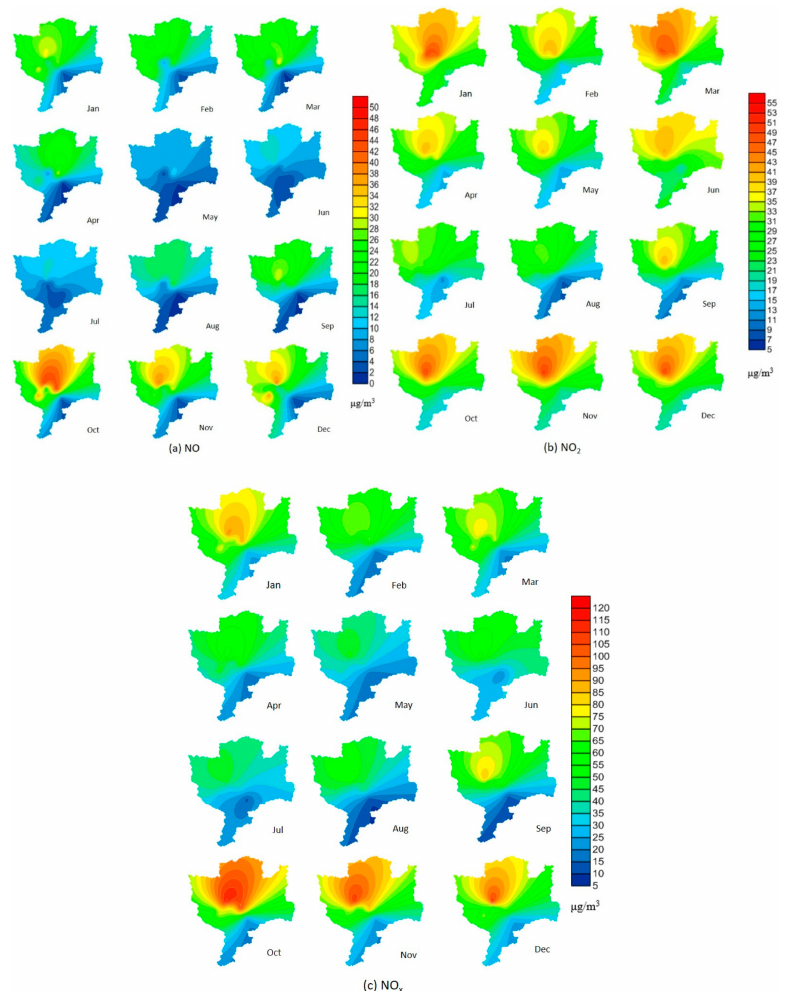
Figure 5. Spatial distribution of the monthly average concentration of nitrogen compounds in Changchun, 2018: ( a ) NO, ( b ) NO 2 , ( c ) NO x